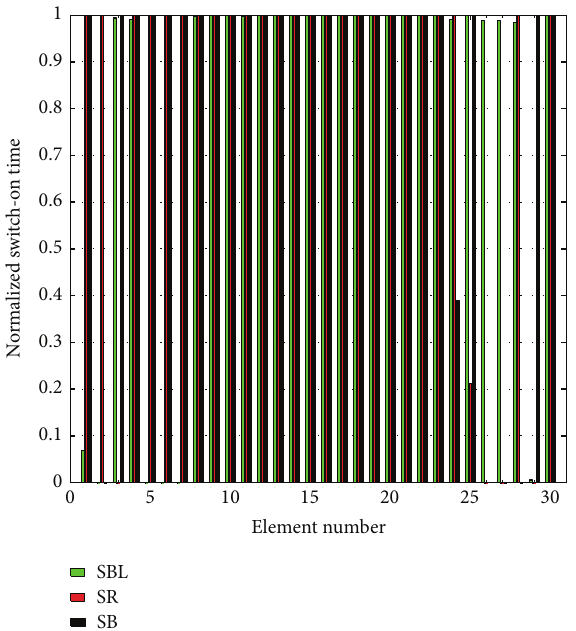
Figure 12: Switch-on time durations of the best converged solution for